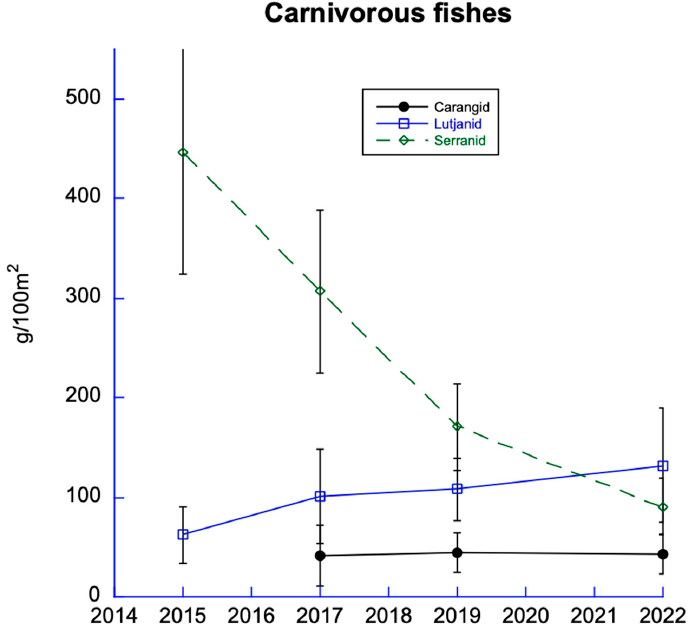
Figure 10. Carnivorous fishes include carangids (jacks), lutjanids (snappers), and serranids (seabass). All were low in abundance, but serranids have declined the most since 2015.